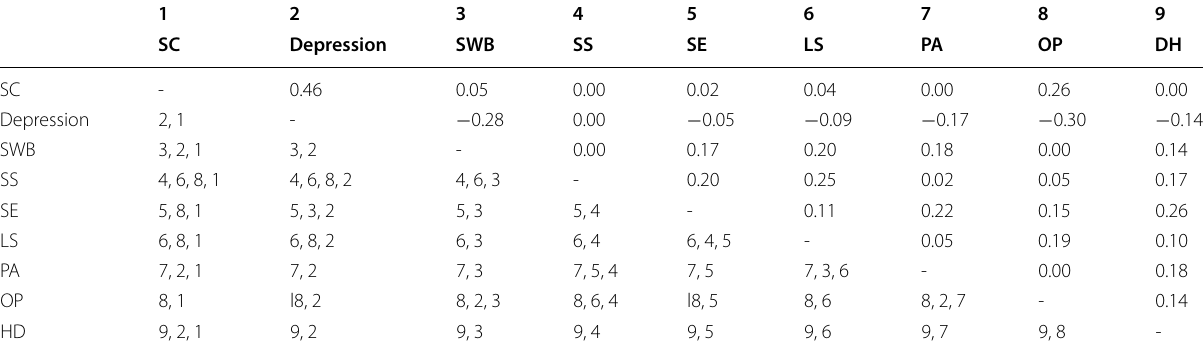
Table 3 Correlated partial correlations above the dotted line and minimum paths below the dotted line between depression, social class, spiritual well-being, social support, self-esteem, life satisfaction, positive affects, optimism, and dispositional